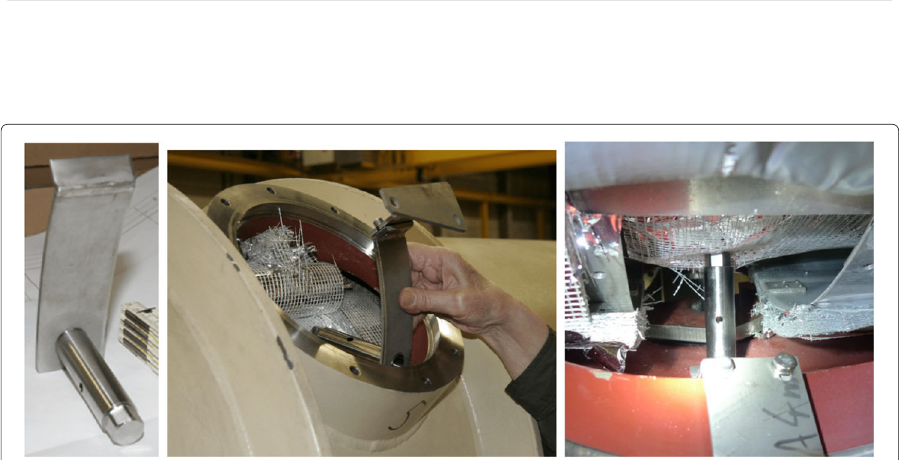
Fig. 12 Left: Middle pressure prop, Middle: Inserting the prop, Right: Inserted pressure prop in the middle of the cryostat